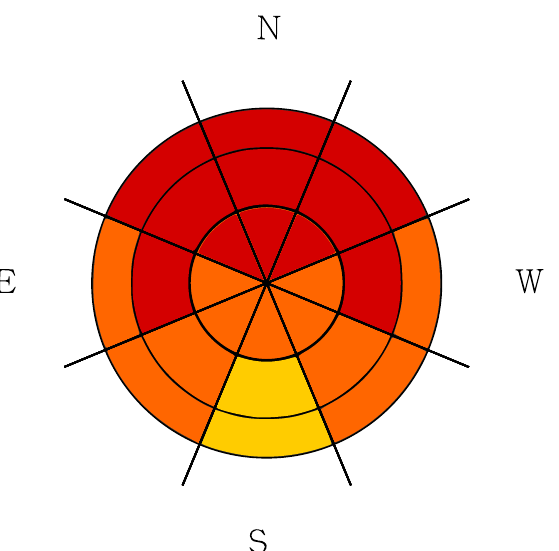
Figure 17. Spatial risk matrix e.g., 50th percentile of the distributions presented in Figure 15 showing the probability of impact considering the event tree represented in. Each circle is proportional radius is proportional to the square root of the leaked volume.